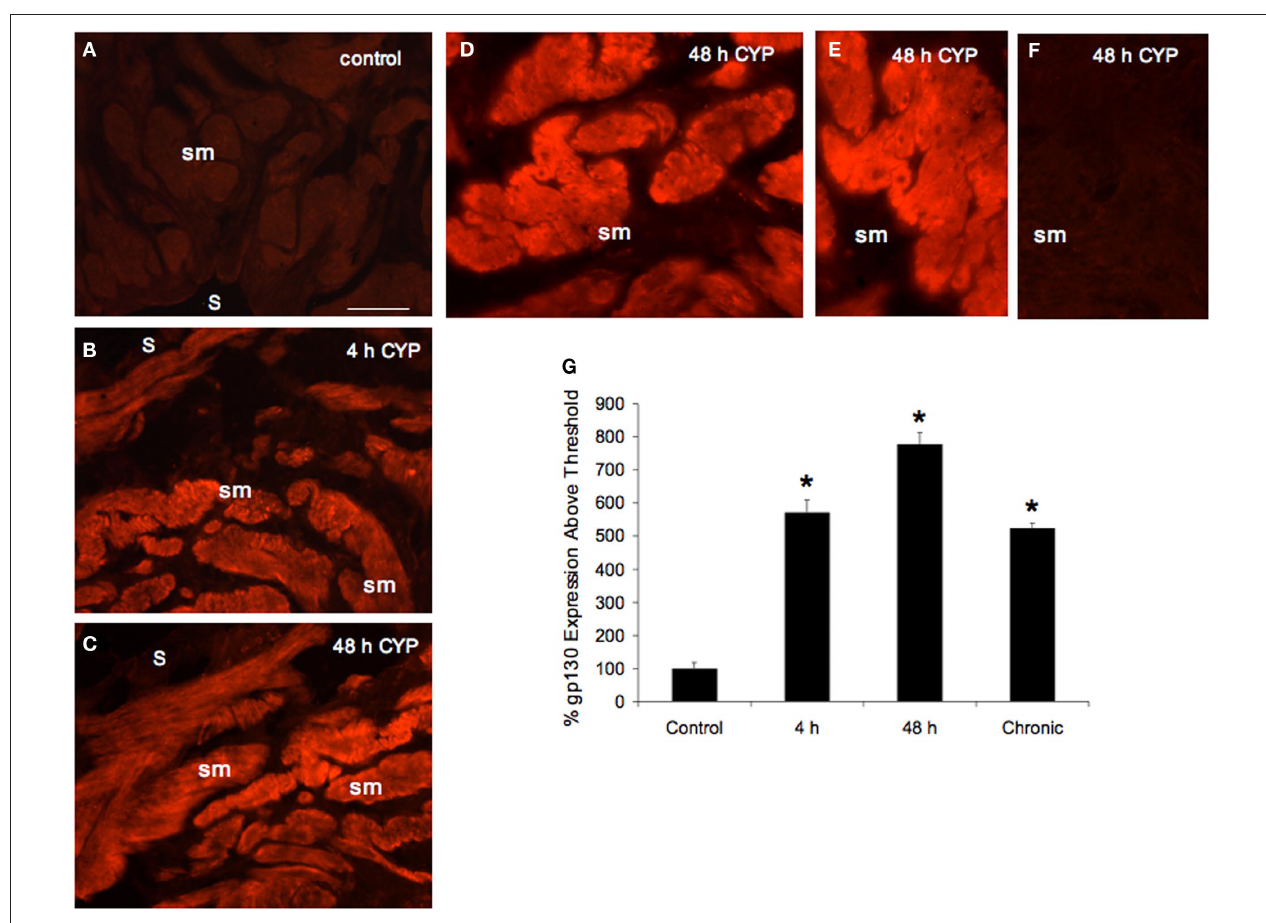
sections resulted in no staining above background. (g) Summary histogram of percent gp130 expression above threshold in sm with CYP-induced cystitis. Data are a summary of n = 6 for each group. * p ≤ 0.01 versus control. S, serosa. Calibration bar represents 80 μm in (A–C,F) , 45 μm in (D) , and 25